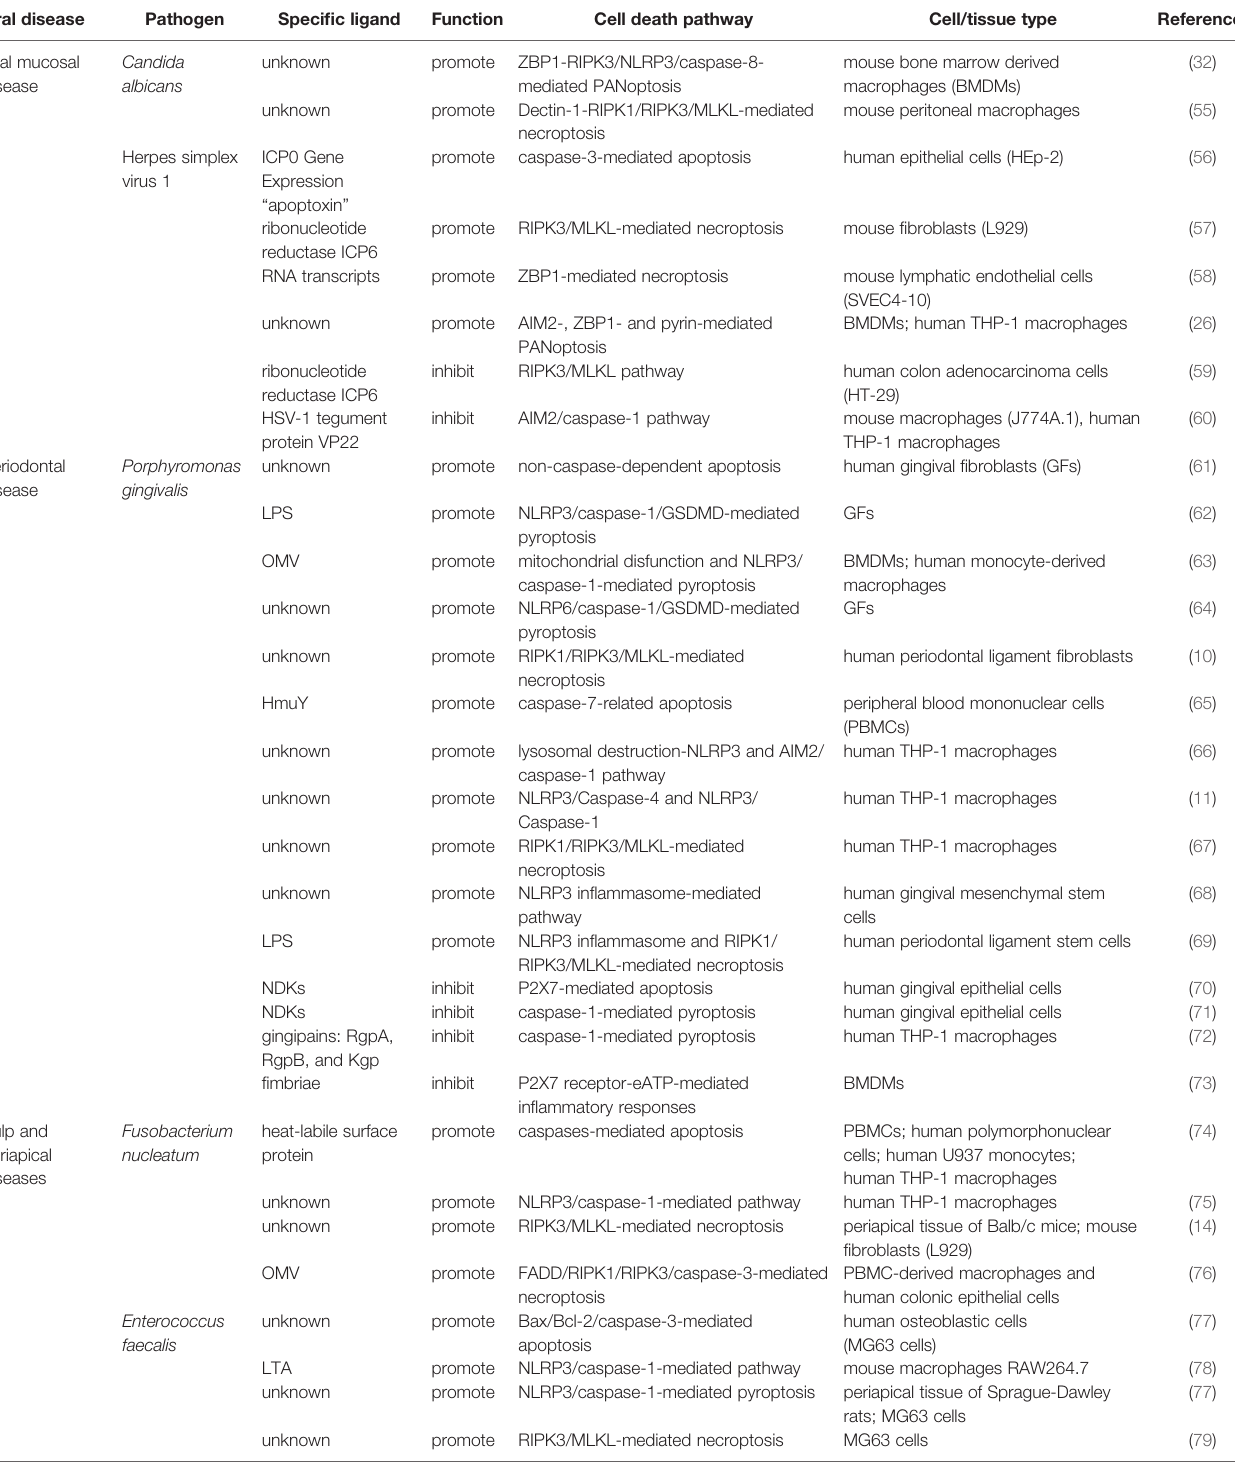
TABLE 1 | Summary of cell death pathways modulated by pathogens in oral infectious